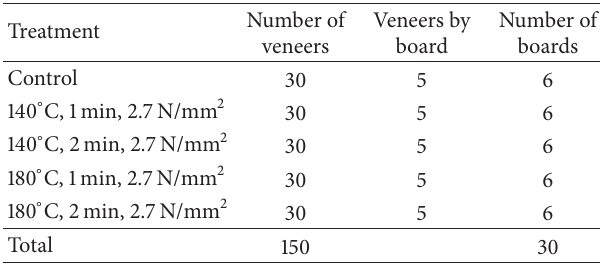
Table 1: Experimental design applied for plywood